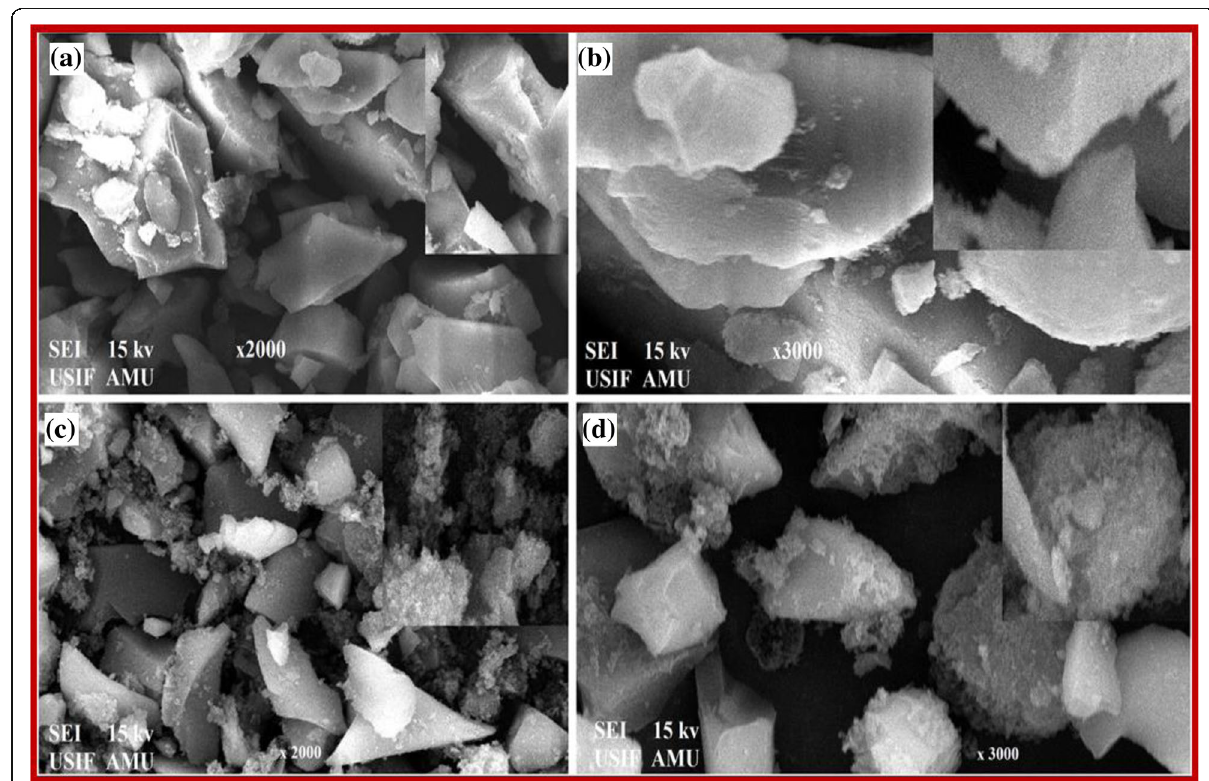
Fig. 3 SEM micrographs of a , b silica gel (S 1 ) and c , d Pani@SG (ES)-S 2 nanocomposite at different